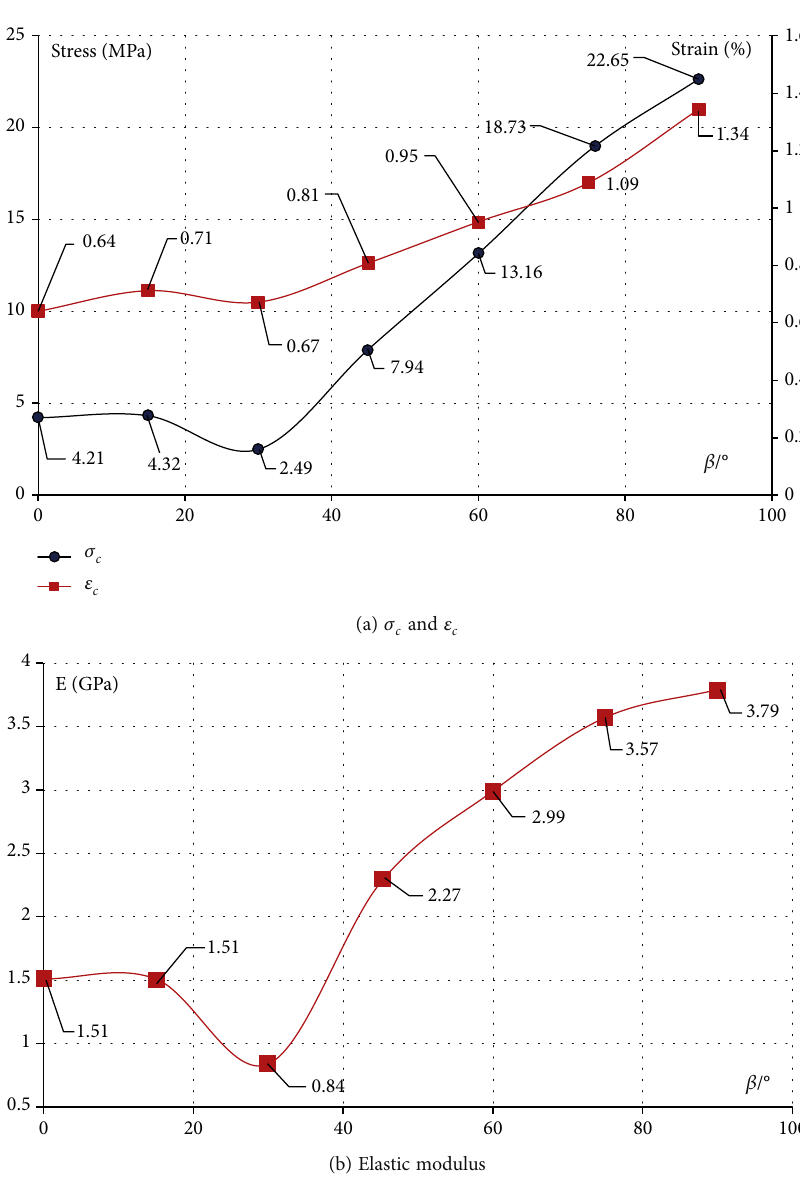
Figure 7: The in fl uences of β on the mechanical properties of rock